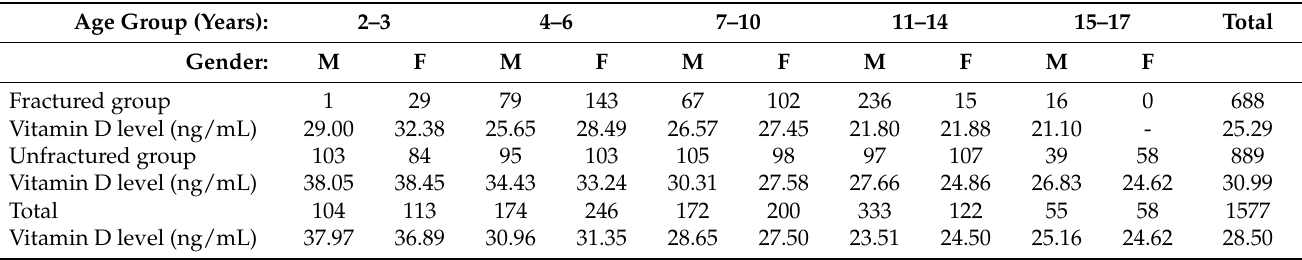
Table 2. Patient distribution according to age group, gender, fractured/unfractured group, and 25-OH-vitamin D level in ng/mL.